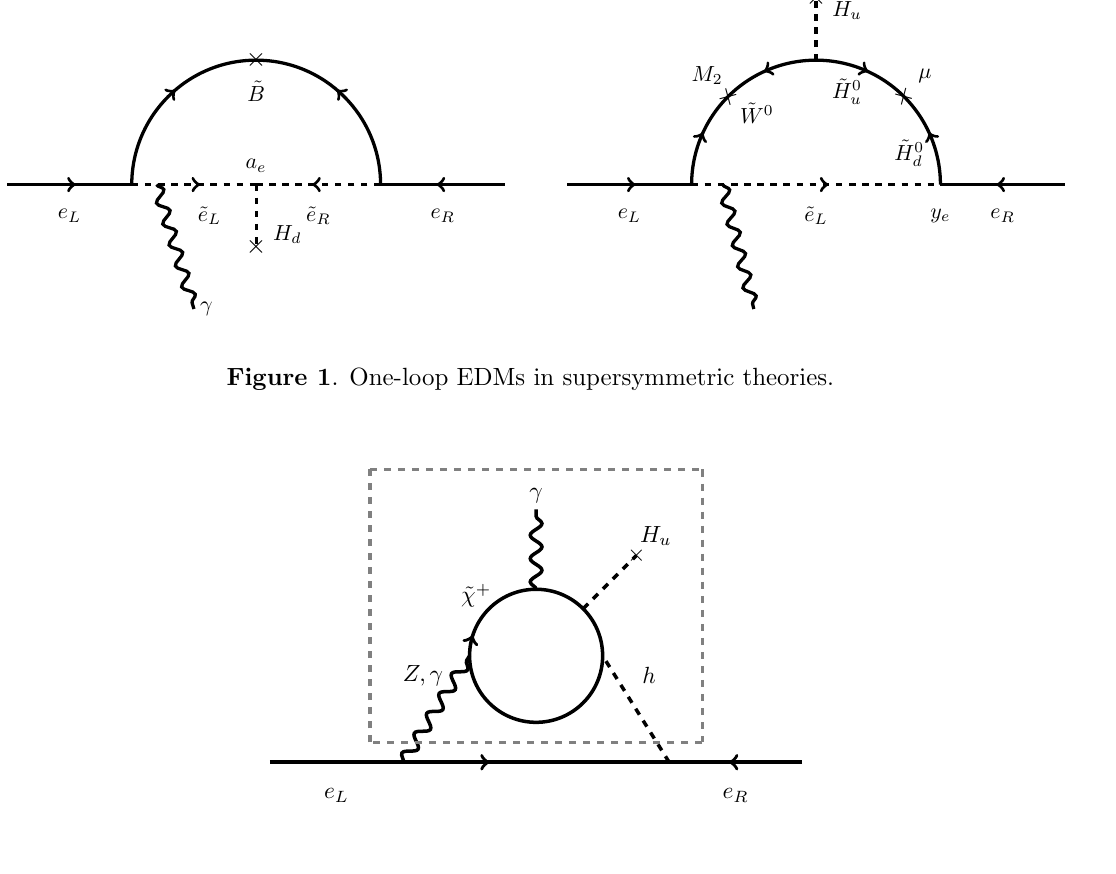
Figure 2 . Two-loop EDMs in supersymmetric theories. The one-loop diagram in the dashed box is a CP-violating analogue of familiar \electroweak precision"